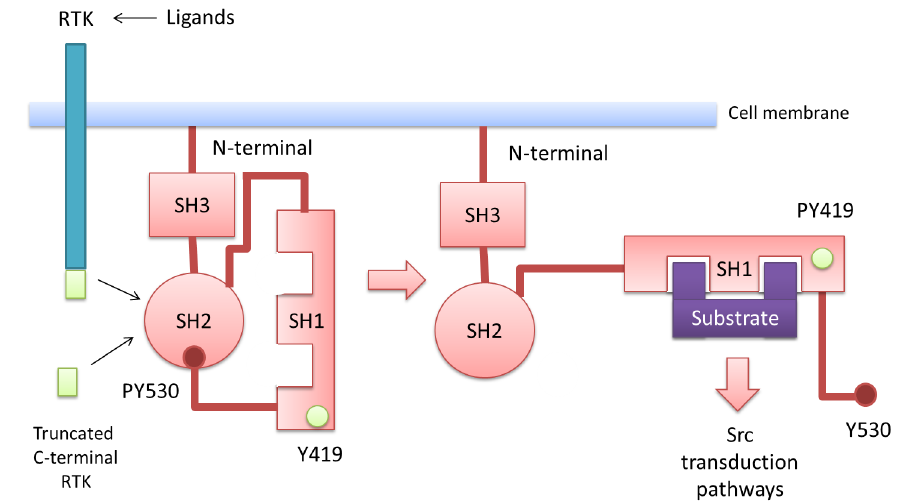
Figure 3. Schematic representation of Src in the low activity state (left) and the active state (right). In the low activity configuration, the SH2 domain binds the phosphorylated C-terminal Tyr 530 , while the SH3 domain interacts with the linker domain, promoting a relative “closed” conformation. In the active configuration, SH2 and SH3 domains are released from the intramolecular interactions with autophosphorylation of Tyr 419 , which enhances the catalytic activity of Src. Activation of Src is mediated by activation of transmembrane tyrosine receptors (RTK) upon binding the corresponding ligands or, alternatively, by the C-terminal intracellular truncated